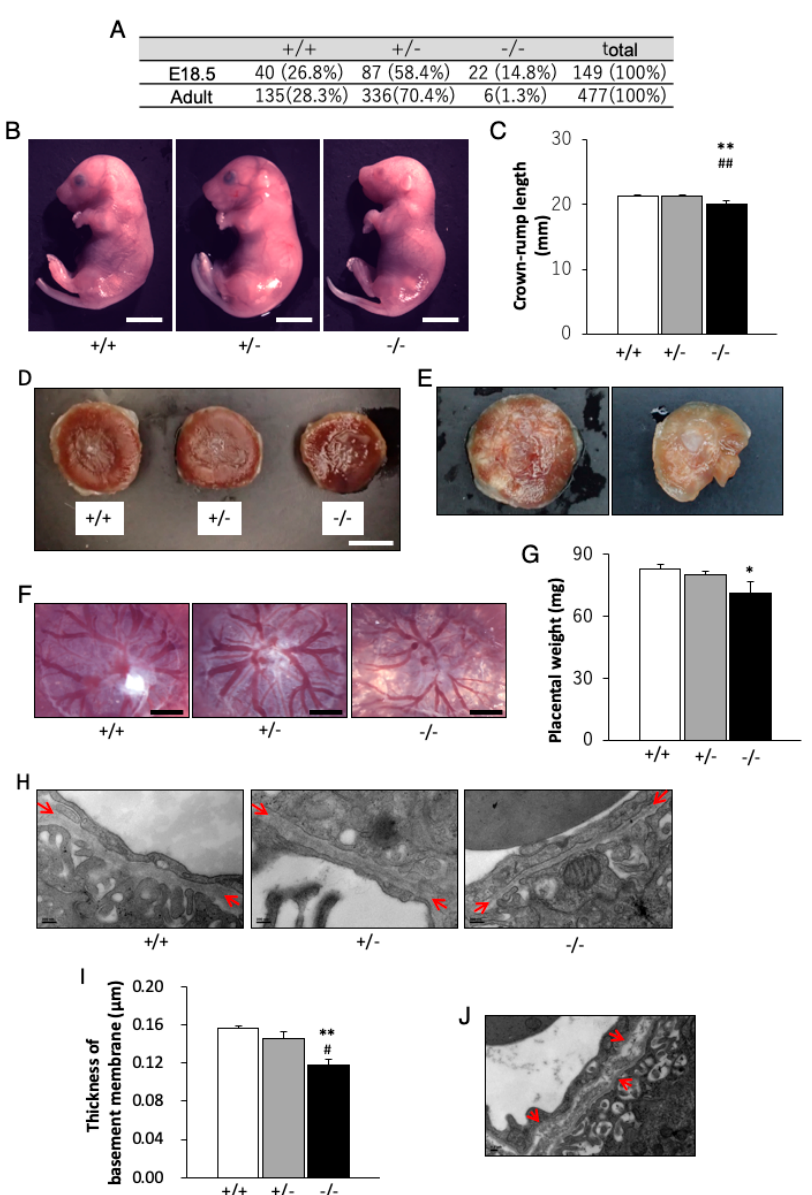
Figure 5. Mouse model for mcEDS- CHST14 . ( A ) Numbers (percentages) of each type at embryonic (E18.5) and postnatal (adult) ages. Markedly greater numbers of homozygous fetuses are observed, compared with homozygous adults. ( B ) General appearances of wild-type ( Chst14 +/+ ), heterozygous ( Chst14 +/- ) and homozygous ( Chst14 -/- ) fetuses [37]. ( C ) Crown-rump length of each type of fetus (bar: 5 mm). Homozygous mice demonstrate significantly shorter crown-rump length, compared with wild-type or heterozygous mice [37]. ( D ) Appearance of each type of placenta (bar: 5 mm) [37]. ( E ) Homozygous placentas exhibit appearances indicative of hypoxia (left) and necrosis (right) [37]. ( F ) Microphotographs of the chorionic plate side of the placentas (bar: 1 mm). Homozygous placentas demonstrate smaller vascular diameters, compared with wild-type or heterozygous placentas [37]. ( G ) Weight of each type of placenta (mean + standard error of the mean). ( H ) Transmission electron microscopy of capillary basement membrane in the labyrinth zone of each type of placenta (bar: 200 nm). Arrows indicate capillary basement membrane [37]. ( I ) Homozygous placentas show a